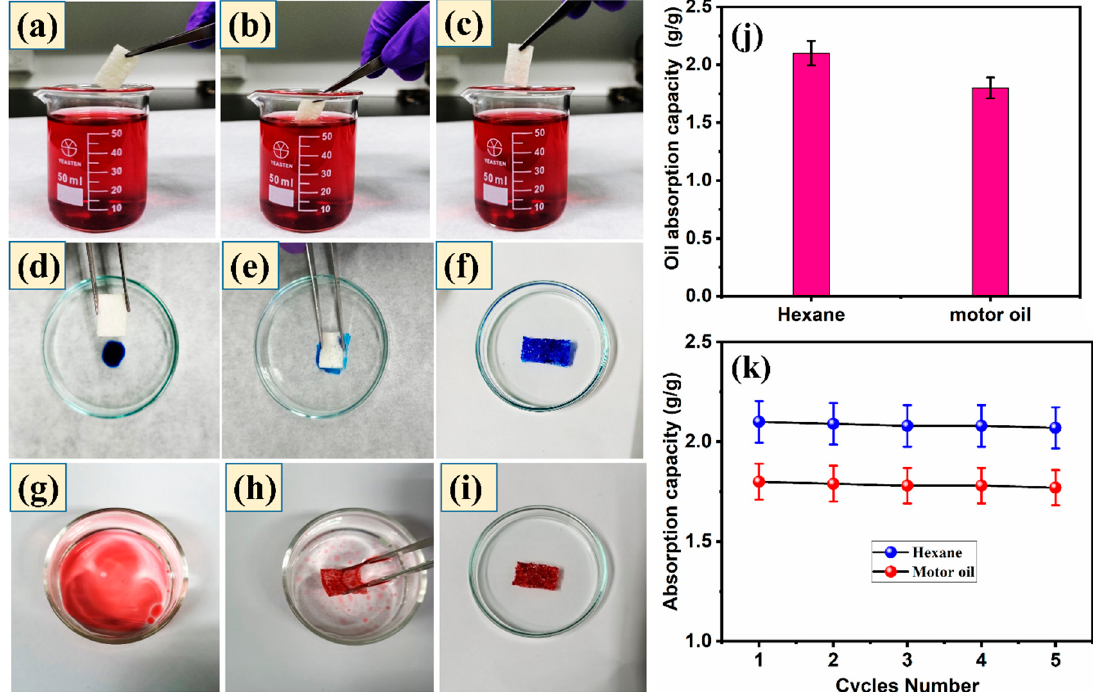
Figure 10. ( a – c ) Images of the PA36,36 foam being immersed in water; ( d – f ) absorbing dyed hexane on the glass surface; ( g – i ) absorbing dyed hexane on top of water; ( j ) absorption capacity of PA36,36 foam towards hexane and motor oil; and ( k ) cyclic absorption traces for PA36,36 foam.